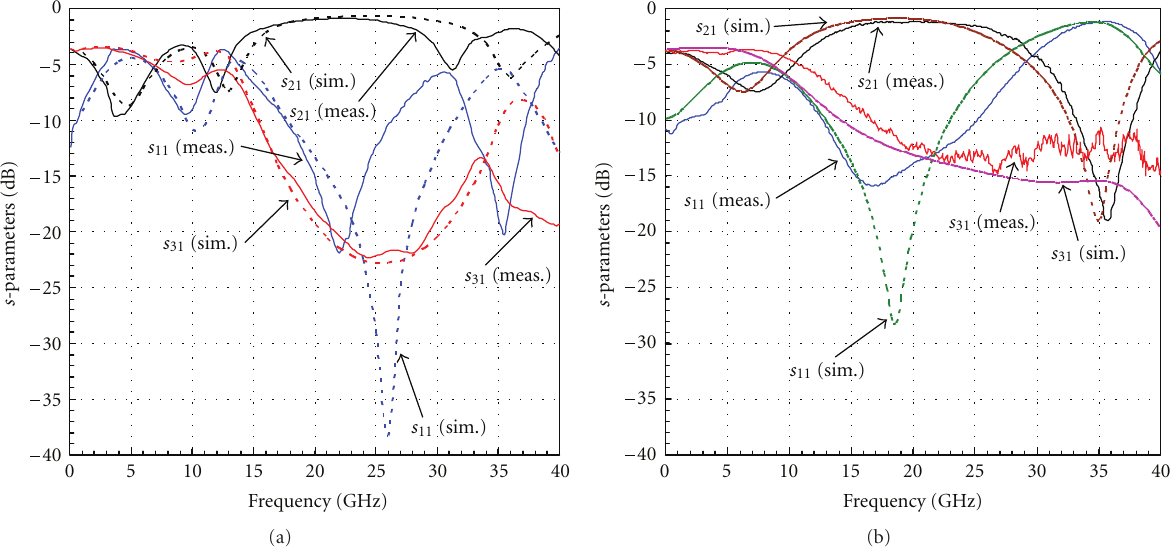
Figure 4: Measured and simulated s -parameters of two types of SPDT switch networks realised using (a) several MEMS switches and (b) a single MEMS switch within each switching branch,